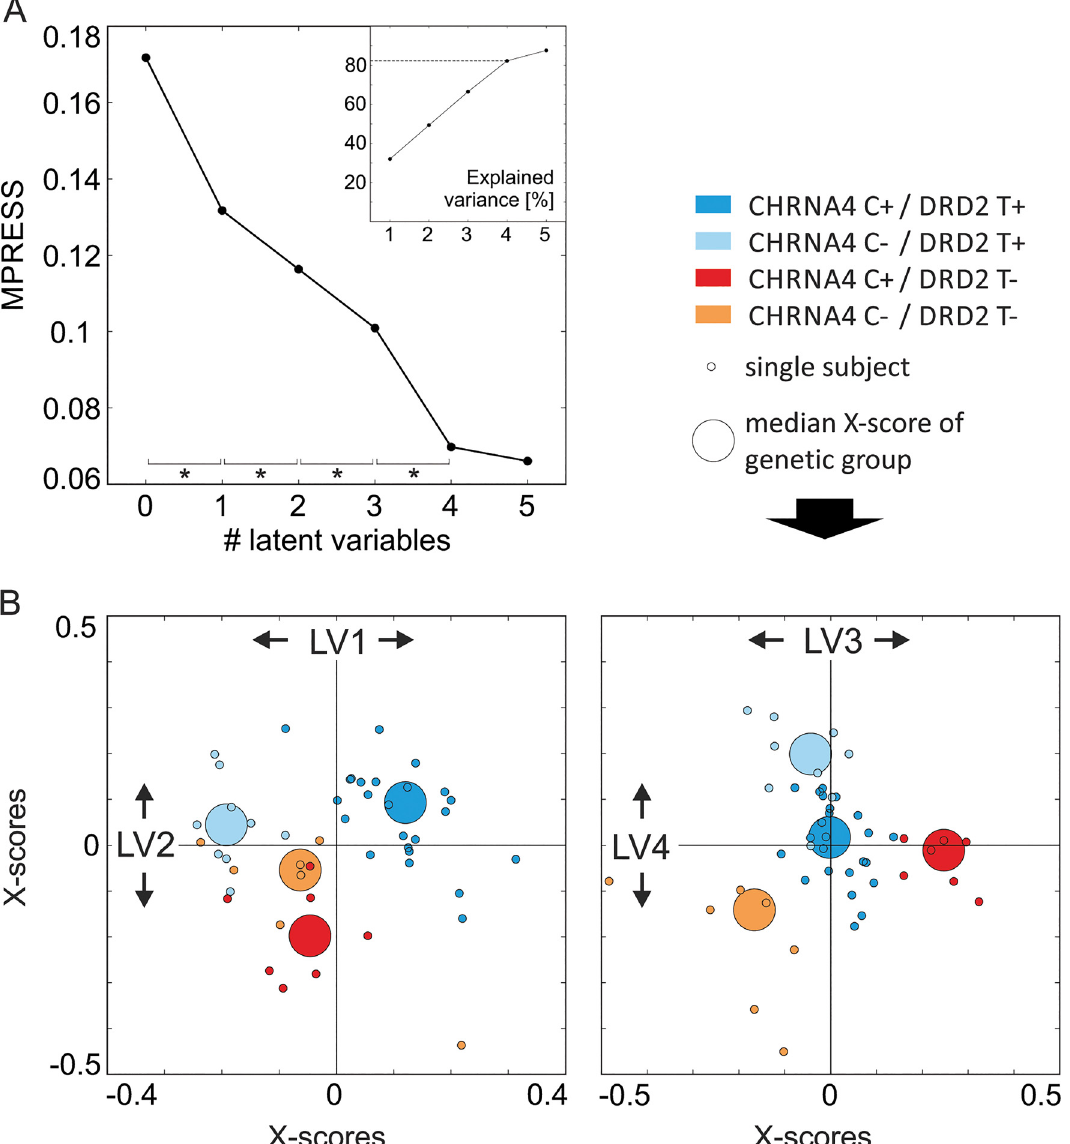
Fig 3. A. Residual errors and explained variance by the latent variables (LVs) of the PLS-DA model. The PLS-DA model derived four significant LVs from the selected voxels (VIP (cid:3) 1.28 as depicted in Fig 2, p-values of LVs (cid:4) 0.05). Voxel values based on the treatment evoked variance of the BOLD responses during the invalid task condition. The four LVs explained in total 82.30% of the model ’ s variance (inlay upper right corner) and were used for classification of the genotype groups. B. X-scores of the latent variables (LVs). Descriptive plot to visualize the discrimination power of the four significant LVs of the current PLS-DA model. The X-scores are the sum of the weighted predictor variables (voxel values) for each LV and depicted here for each subject (small dots). For illustration, the colour code is set to the true genotype group of each subject, large dots represent the median X-score of each group. The plot shows how the PLS-DA model projects the original X data space in order to optimize the covariance between the genotype groups and X-scores. It is visible that, for example, the first LV (x-axis of the left plot) differentiates well between the prevalent CHRNA4 C+ / DRD2 T+ carriers (coloured in darker blue, positive X-scores for LV1) and the other three genotype groups (negative X-scores for LV1). The third LV (x-axis of the right plot) differentiates well between e.g. the third genotype group, which showed the behavioural benefits of nicotine (red, positive X-scores for LV3) and the fourth genotype group, (orange, negative X-scores for LV3), but not between the first two genotype groups (blue colours, X-scores around zero). Note that the information of all four LVs is used in the PLS-DA classification to predict the genotype group of the